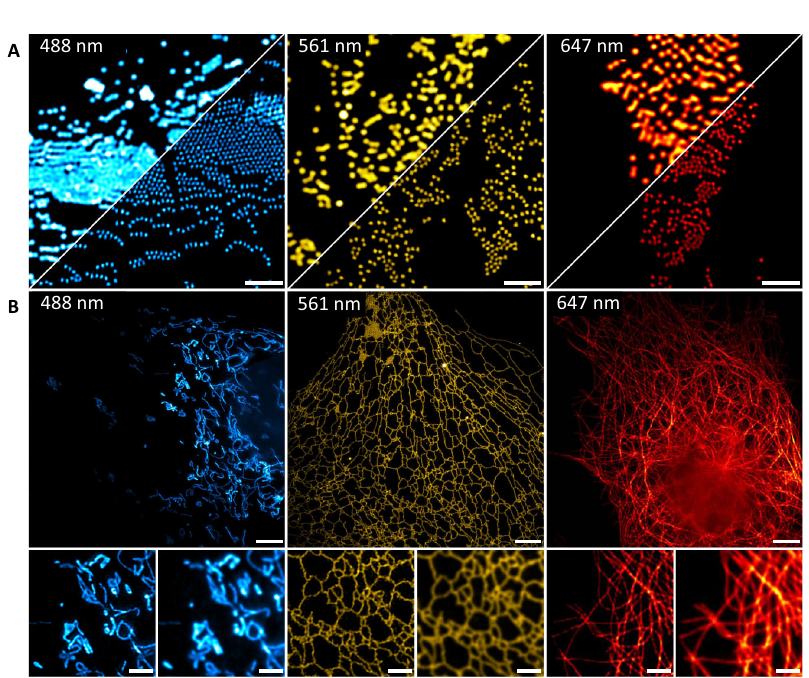
Fig. 5 | Multicolor imaging capability of the developed instrument. A 200nm TetraSpeck microspheres imaged with excitation/emission wavelengths of